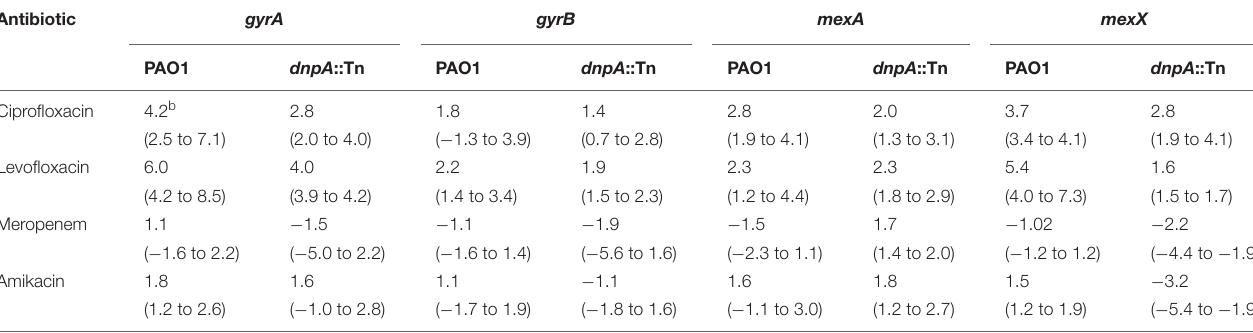
TABLE 4 | Relative mRNA a expression levels of gyrA , gyrB , mexA , and mexX genes after exposure of PAO1 and its dnpA insertion mutant to different antibiotics. Antibiotic